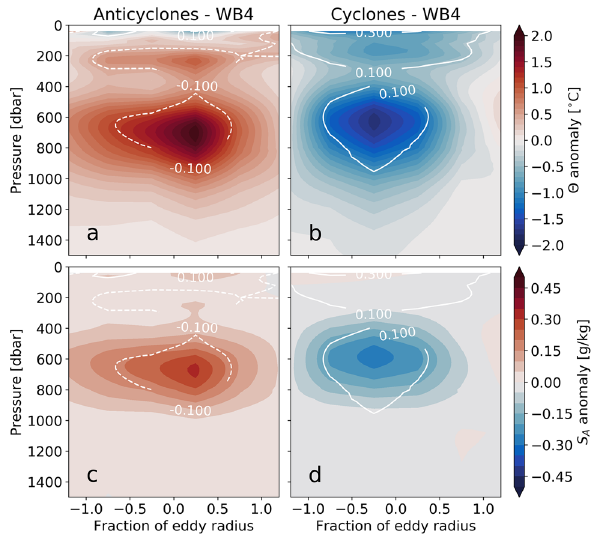
Figure 4. Mesoscale eddy properties at the RAPID/MOCHA mooring WB4. ( a ) Mean (cid:31) anomaly of anticyclonic eddies that pass RAPID/MOCHA mooring WB4. Mooring observations of (cid:31) anomaly are binned according to the distance (normalised with respect to the eddy radius) of the eddy from the mooring. The value at a given eddy radius fraction is therefore the mean of all eddies that passed within that fraction of the eddy − 3 radius. White contours show ρ anomaly (units kg m ). ( b ) As in ( a ) but for cyclonic eddies. ( c ) As in ( a ) but showing mean S A anomaly. ( d ) As in ( b ) but showing mean S A